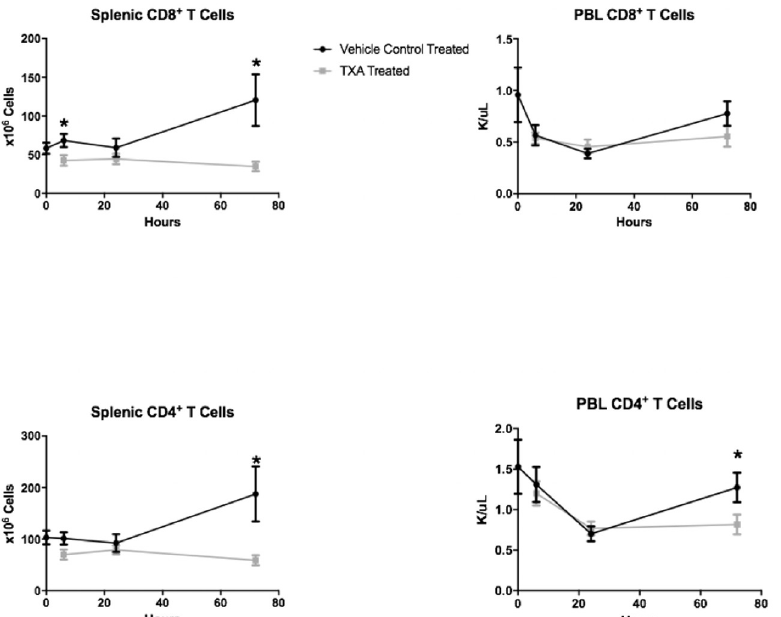
Fig 2. Fluorescence-activated cell sorting (FACS) analysis of splenic and peripheral blood (PBL) CD8+ and CD4+ T cell levels in rats subjected to controlled hemorrhagic shock and resuscitation, vehicle control (normal saline) treated vs. tranexamic acid (TXA) treated, 300mg/kg ( � p < 0.05, error bars =